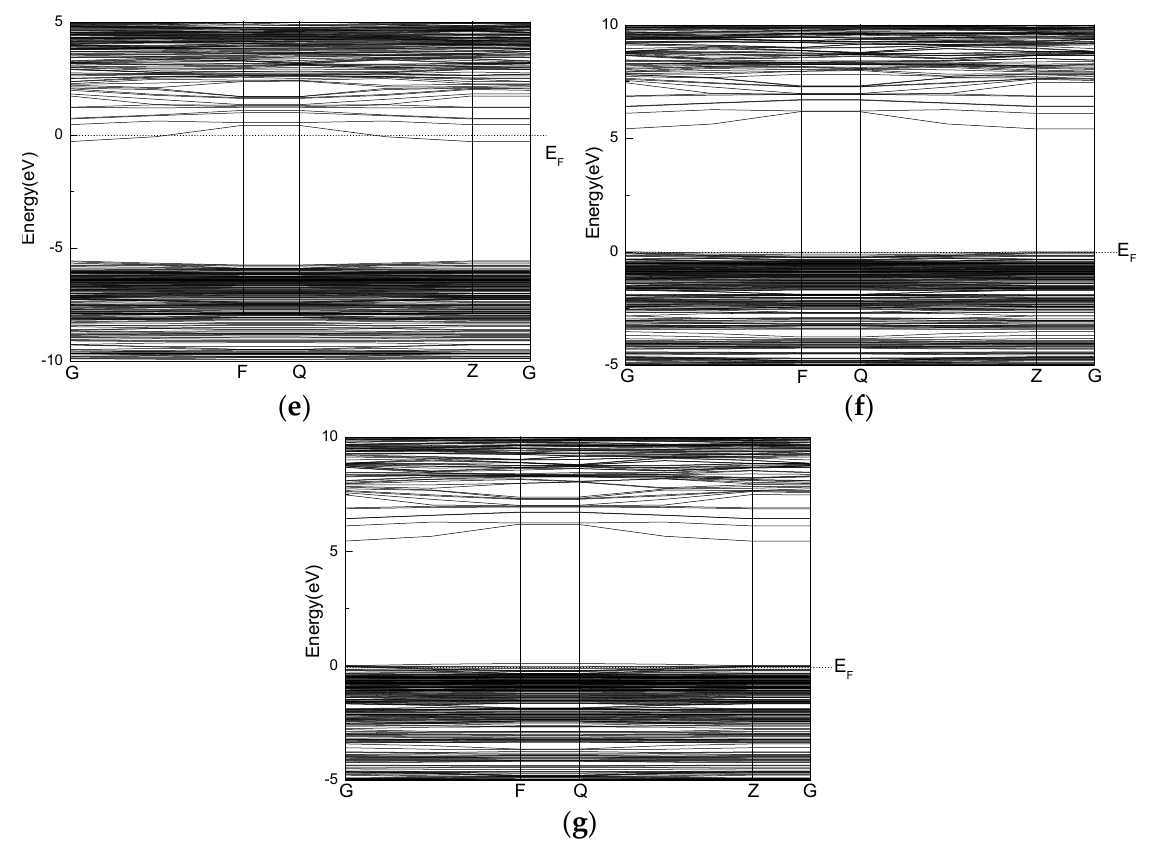
Figure 7. Energy band structure of the ideal talc surface and the point defect surface: ( a ) ideal surface, ( b ) Fe impurity defect surface, ( c ) Mn impurity defect surface, ( d ) Ni impurity defect surface, ( e ) Al impurity defect surface, ( f ) Ca impurity defect surface, and ( g ) Mg vacancy defect surface.